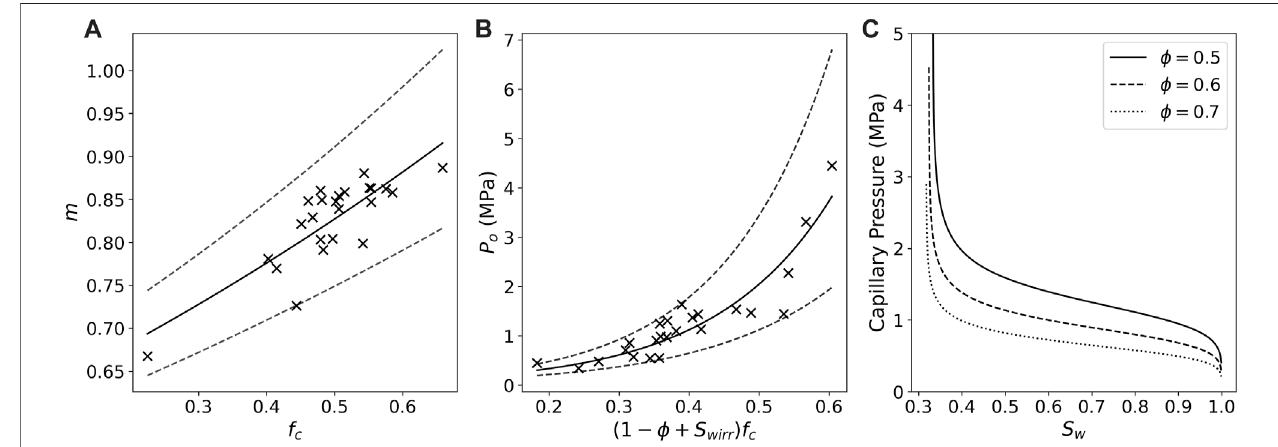
FIGURE 3 | Best fi t lines for van Genuchten parameters (A) m ( Eq. 6 ) and (B) P o ( Eq. 7 ). Error bars of ±1 standard deviation are represented by gray dashed lines. Black X ’ srepresent MICPmeasurements performedon marinesediments. (C) Watersaturationgraphedagainst capillary pressurefor porosity ϕ =0.5(solid line), ϕ =0.6 (dashed line), and ϕ =0.7 (dotted